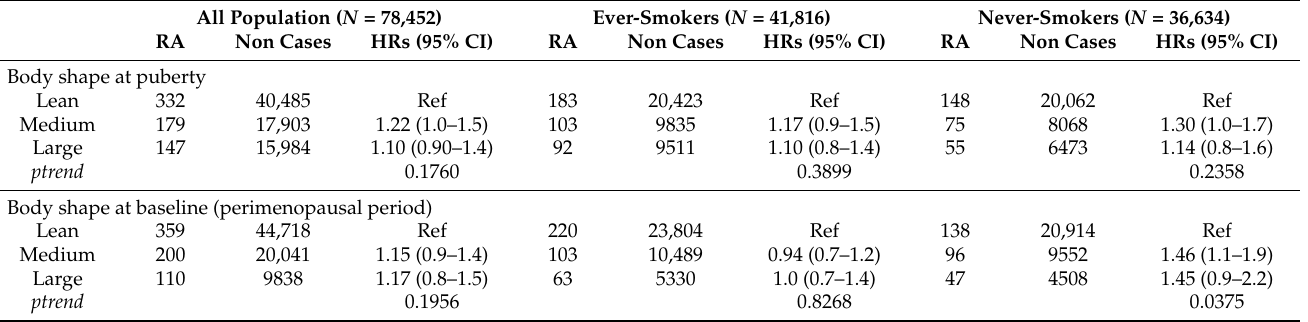
Table 2. Hazard ratios (95% confidence intervals) for the risk of RA by body shapes at puberty and at baseline in multi-adjusted model (for the overall population, ever-smokers, and